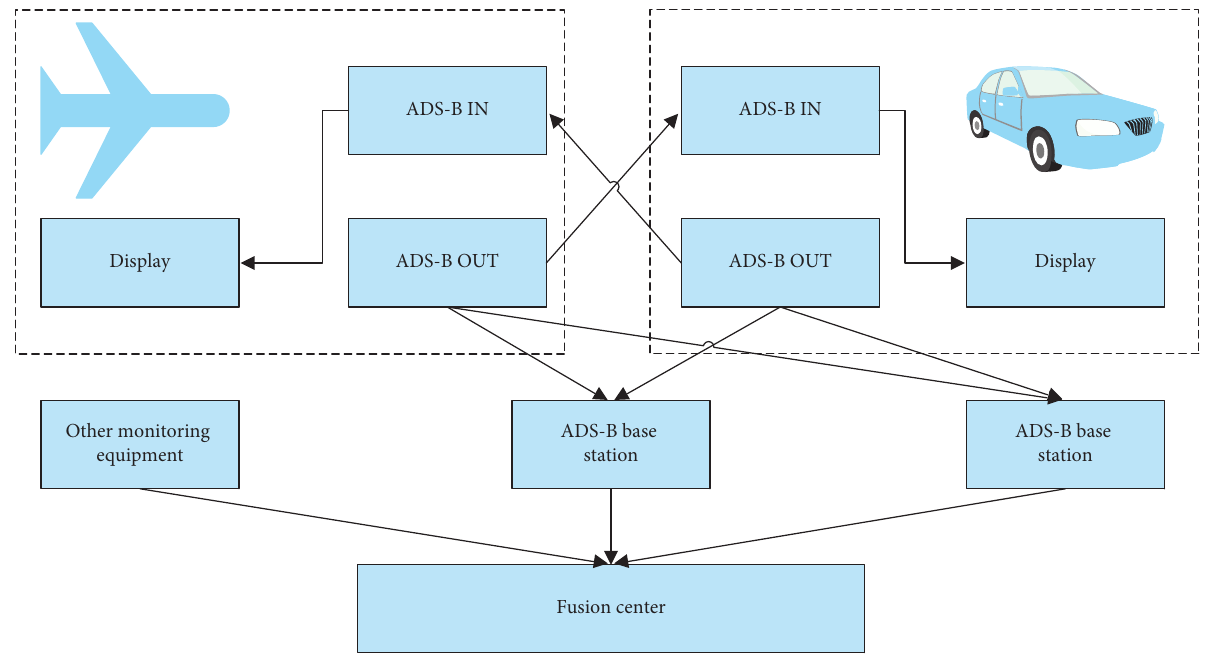
Figure 2: Schematic diagram of a surface surveillance system based on table. The ADS-B track update cycle is the update cycle of the